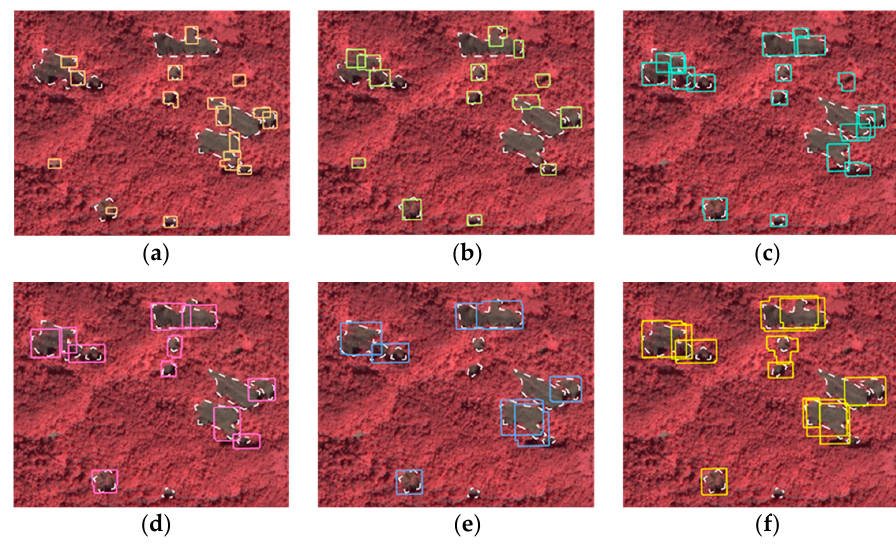
Figure 21. Performance of the model for different image resolutions: ( a ) 1.5 m, ( b ) 2.0 m, ( c ) 2.5 m, ( d ) 3.0 m, ( e ) 3.5 m, and ( f ) 4.0 m.